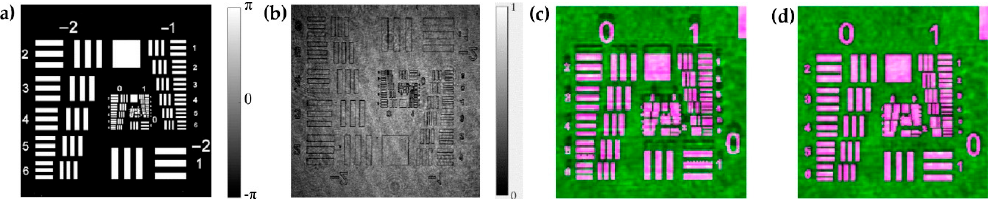
Figure 3. Pixel alignment of the DOPC system. ( a , b ) The phase pattern of a negative United States Air Force (USAF) target and image obtained by CCD1; ( c ) the image subtraction in the case of inaccurate alignment; ( d ) the image subtraction in the case of fine-tuned alignment. The magenta part in Figure 3c,d are the the images loaded by the SLM; The green image is the CCD1 image.